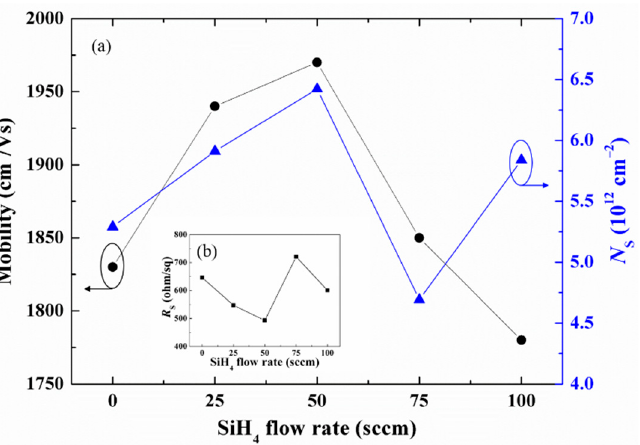
Figure 4. ( a ) Bright-field cross-sectional STEM micrograph of GaN-based HEMT structure on Si (111) with the SiN x nano-mask grown under 100 sccm SiH 4 flow rate and ( b ) Selective area electron diffraction pattern of the HT-GaN top layer taken along the [11(cid:3364)00] zone axis.